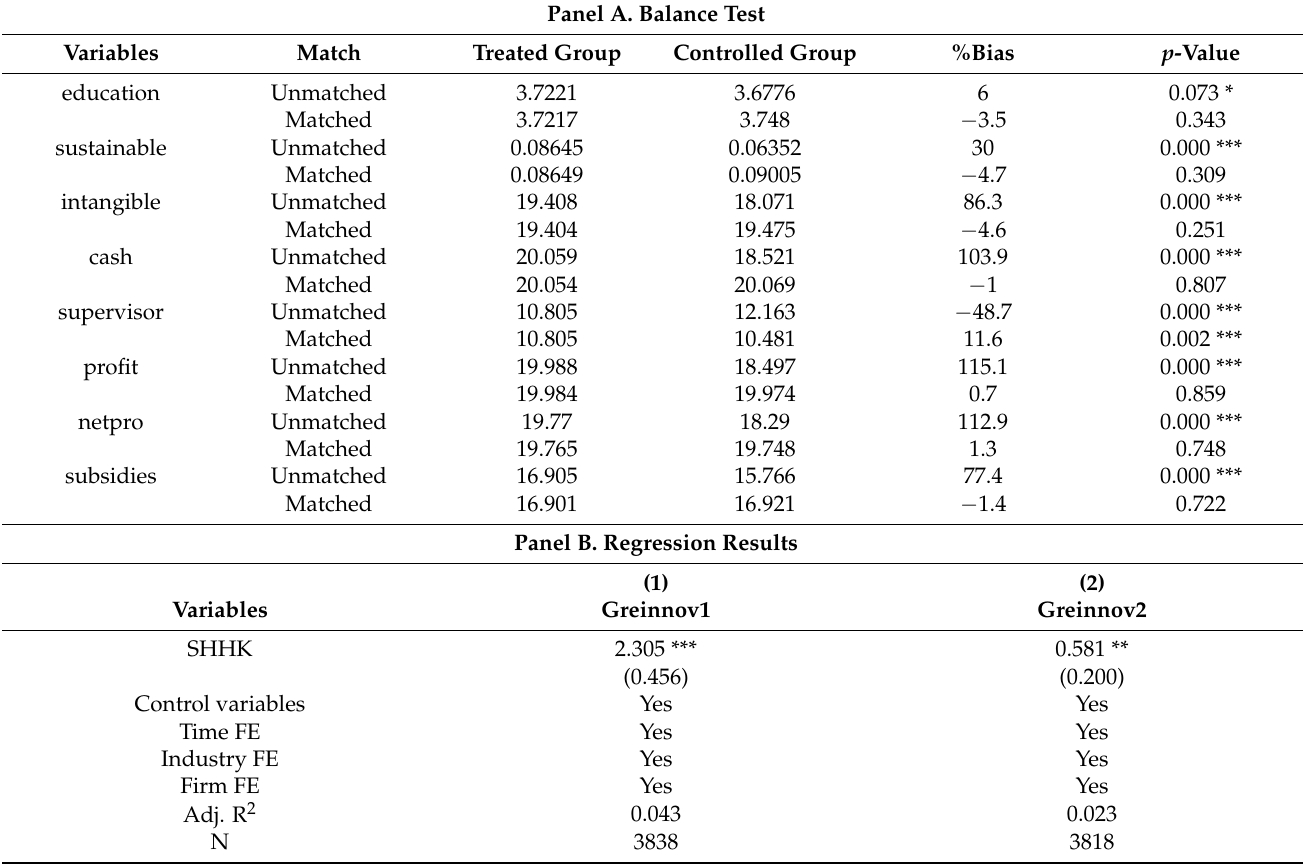
Table 4. Results of propensity score matching difference in differences (PSM-DID) method. Panel A. Balance Test